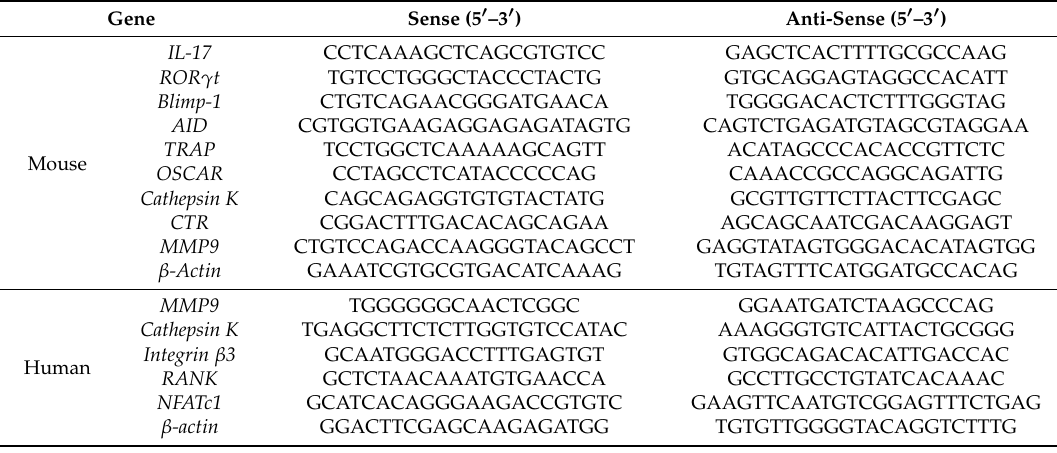
Table 1. Primer sequences for real-time